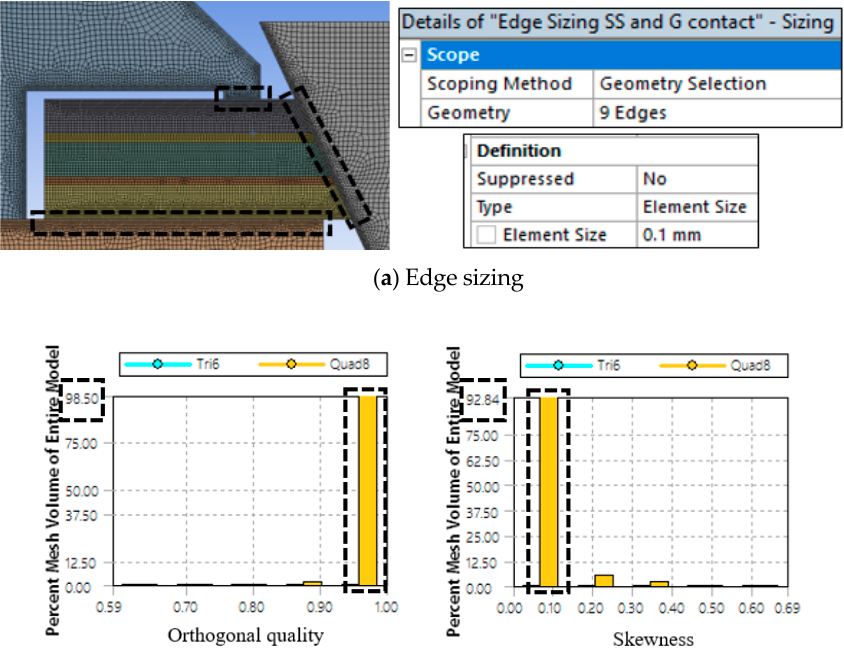
Figure 14. Generation of mesh.